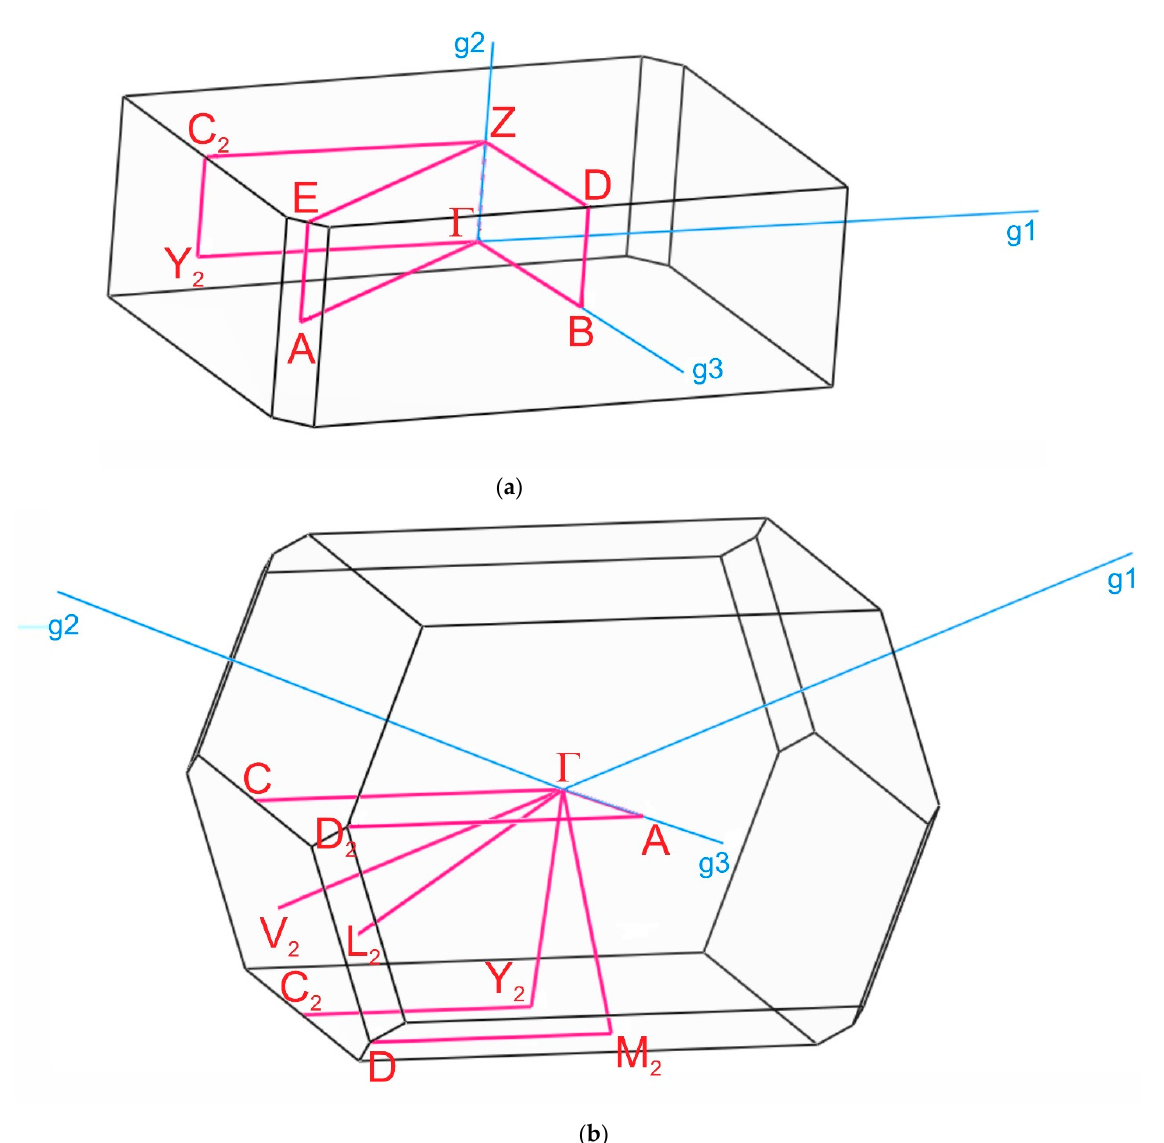
Figure 8. Brillouin zones of ( a ) [CsEu(H 2 O) 3 (SO 4 ) 2 ]·H 2 O and ( b ) CsEu(SO 4 ) 2 . The calculated electronic band structures of [CsEu(H 2 O) 3 (SO 4 ) 2 ]·H 2 O and CsEu(SO 4 ) 2 are shown in Figure 9. The bandgap calculated value was determined as the difference between the valence band top (VBT) and the conduction band bottom (CBB). As europium is a lanthanide, the band structure was presented as spin up and spin down components. The VBT and CBB points of [CsEu(H 2 O) 3 (SO 4 ) 2 ]·H 2 O and CsEu(SO 4 ) 2 were located in the center of the Brillouin zone (see Figure 9) and, thus, we can say that both compounds were direct band gap materials. The calculated bandgap value for [CsEu(H 2 O) 3 (SO 4 ) 2 ]·H 2 O was 5.09 eV, while, for CsEu(SO 4 ) 2 , E g = 3.30 eV. Thus, the transformation from the hydrate to the anhydrous compound reduced the bandgap value in the pair of sulfates.